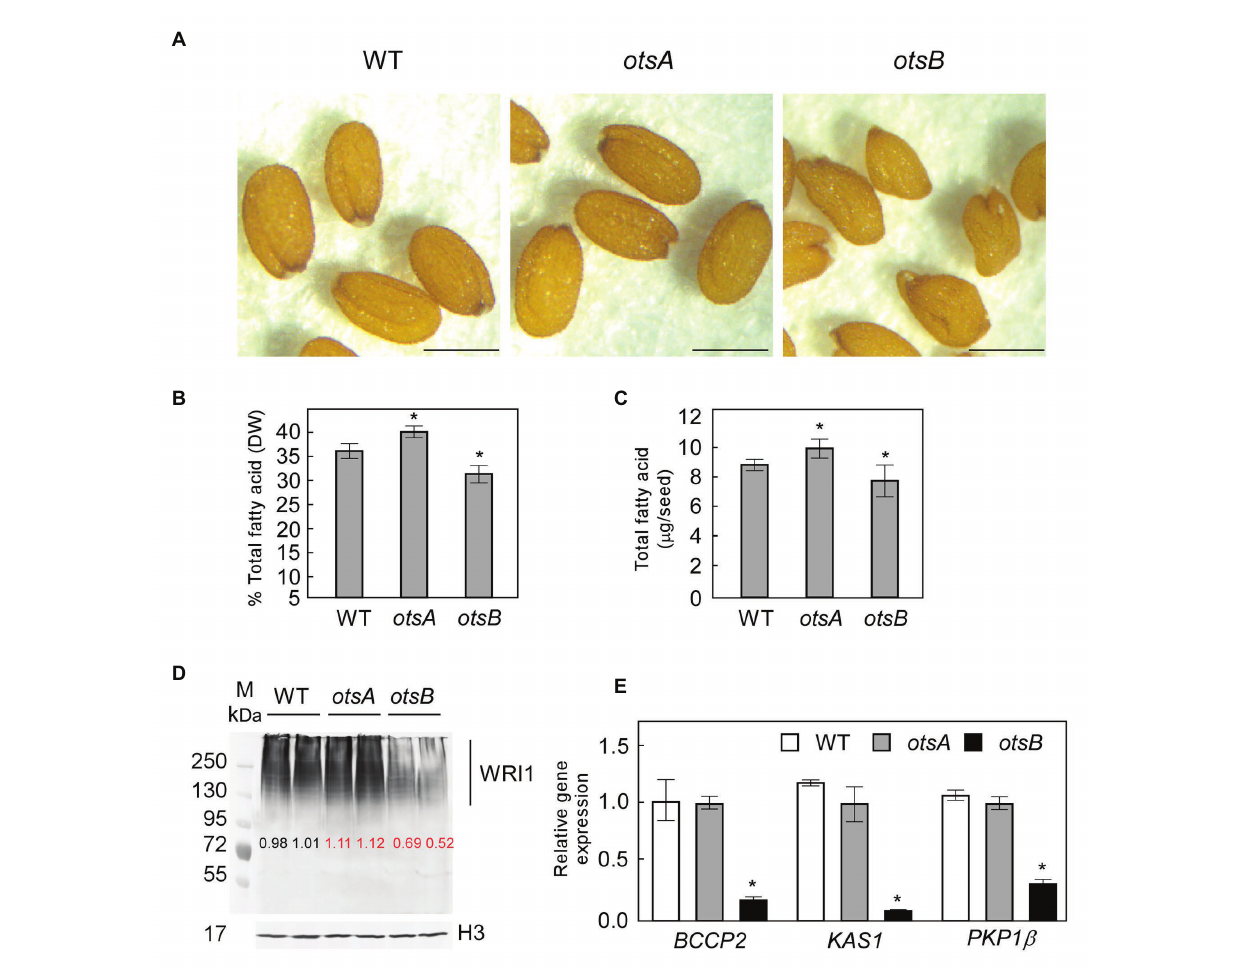
FIGURE 1 | Expression of a bacterial trehalose 6-phosphate (T6P) synthase (TPS) otsA in Arabidopsis increases seed fatty acid content by stabilizing WRINKLED1 (WRI1). (A) Representative phenotype of seeds of wild type (WT) Arabidopsis and of 35S:otsA - and 35S:otsB -expressing transgenic lines. Bar = 0.2 mm. Seed total fatty acid contents are presented on percentage dry weight (DW; B ) and per seed (C) basis. Values represent mean ± SD, n = 5 for each sample of 30 seeds. Asterisks denote statistically significant difference from WT (Student’s t -test, * p < 0.05). (D) Levels of WRI1 in developing siliques [10 days after flowering (DAF)] were quantified from four biological replicates with GelAnalyzer2010 and normalized to the level of histone H3 (H3) in respective samples. A representative immunoblot is shown. Numbers in red indicate significant differences in mean levels from those of WT (Student’s t -test, p < 0.05). (E) Expression levels of three of the gene targets of WRI1: BCCP2 , KAS1 , and PKP-1 b. Values are means ± SD ( n = 3) from three independent experiments. Transcript abundance is expressed relative to WT. For each experiment, total RNA was isolated from siliques (10 DAF) from WT, 35S:otsA , and 35S:otsB transgenic plants. Asterisks denote statistically significant differences from WT [using mean crossing point deviation analysis computed by the relative expression (REST) software algorithm, * p <